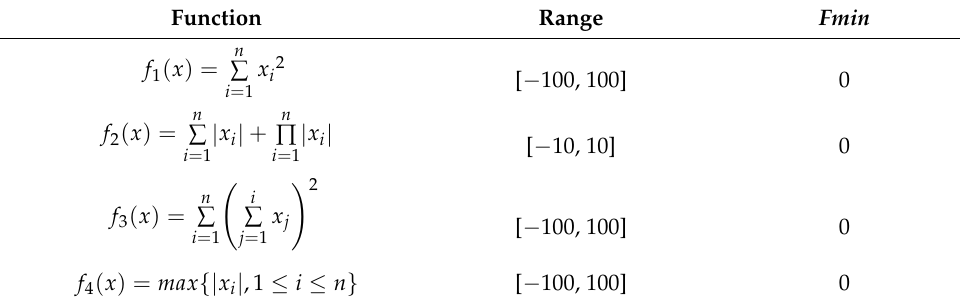
Table 1. Four high-dimensional single objective functions (Dim = 30).